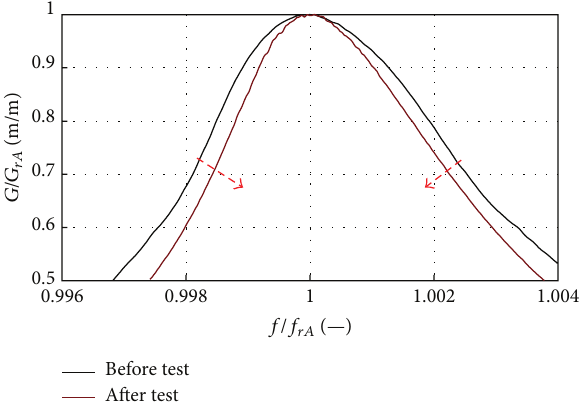
Figure 29: Changes in modal parameters during material strength- ening phase [3, 23].